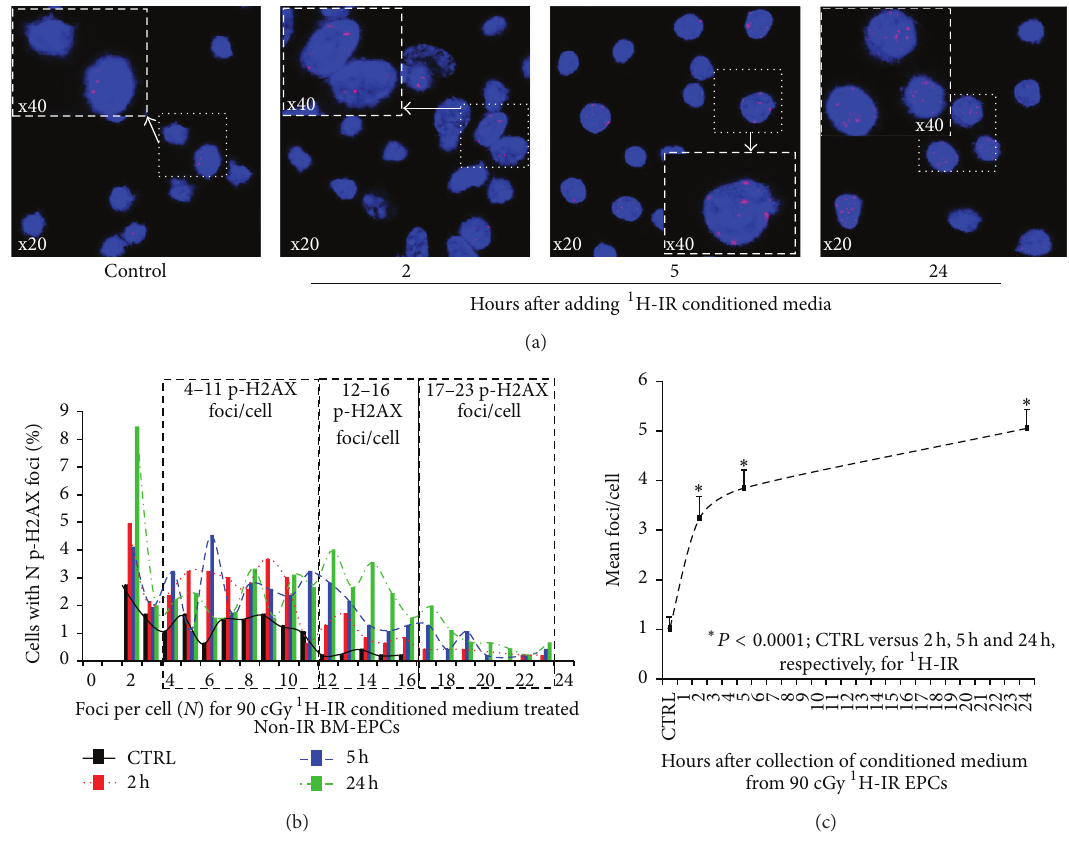
Figure 2: Nonirradiated BM-EPCs treated with 1 H-IR conditioned media exhibit increased number of p-H2AX foci/cell in vitro . (a) Representative confocal images of p-H2AX 24 h after treatment of Non-IR BM-EPCs with 1 H-IR-CM medium collected from duplicate set of respective BM-EPCs 2, 5, and 24 hours after 90 cGy 1 H-IR. (b) Mean p-H2AX foci distribution (with ≥ 2 p-H2AX foci/cell) in BM-EPCs treated with Non-IR and 1 H-IR conditioned media (CM). Foci distribution plot for % of Non-IR BM-EPCs with a given number ( 𝑁 ) of foci after treatment for 24 h with CM from 90cGy 1 H-IR BM-EPCs at 2h (red bars and dotted lines), 5h (blue bars and dashed lines), and 24 h (green bars and dashed/dotted lines) compared to Non-IR controls (black bars and solid lines). For clarity of data presentation and due to no difference in the number of p-H2AX foci/cell between Non-IR and 1 H-IR treatment groups, graphs represent distribution of p-H2AX foci/cell after excluding the cells with zero and 1 foci/cell. (c) Mean p-H2AX foci/cell plotted for control, 2 h, 5h, and 24 h time points after treatment of Non-IR BM-EPC with 1 H-IR CM. Graphs represent mean ± SEM of the pooled data from 5-6 independent biological samples/experiments. Statistical significance was assigned when 𝑃 < 0.05 .